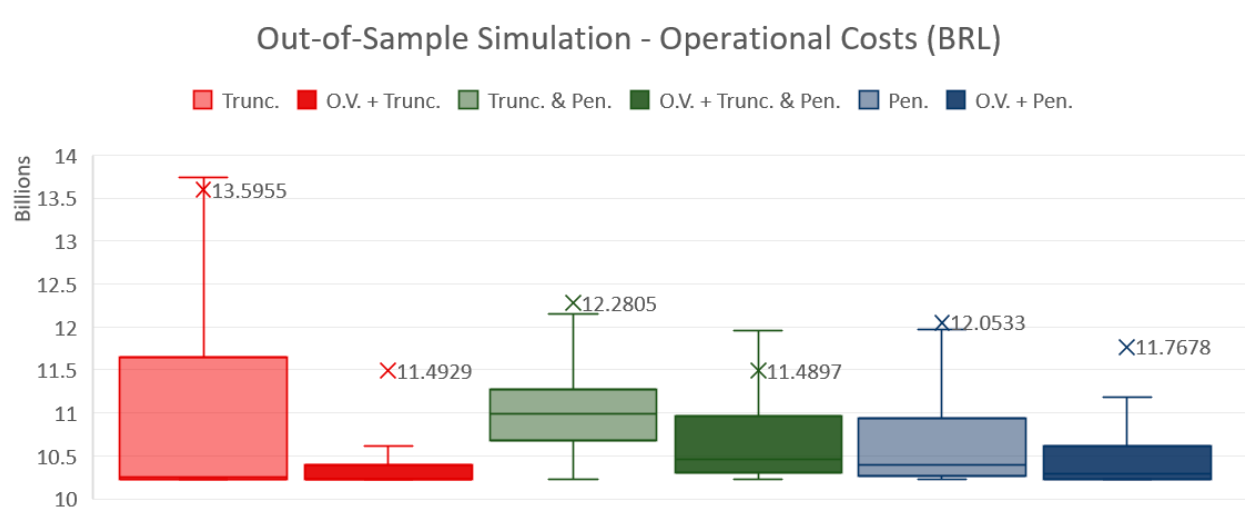
Figure 14. Operational costs (BRL) from the out-of-sample simulation. The X’s represent the average operational cost.